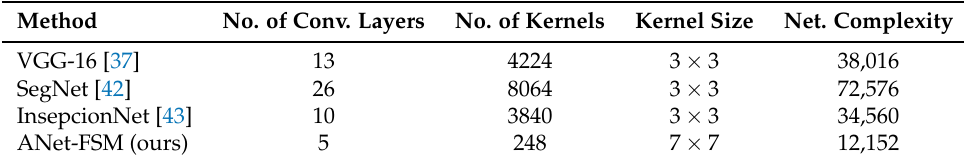
Table 3. Comparison of network complexity of different encoder-decoder-based